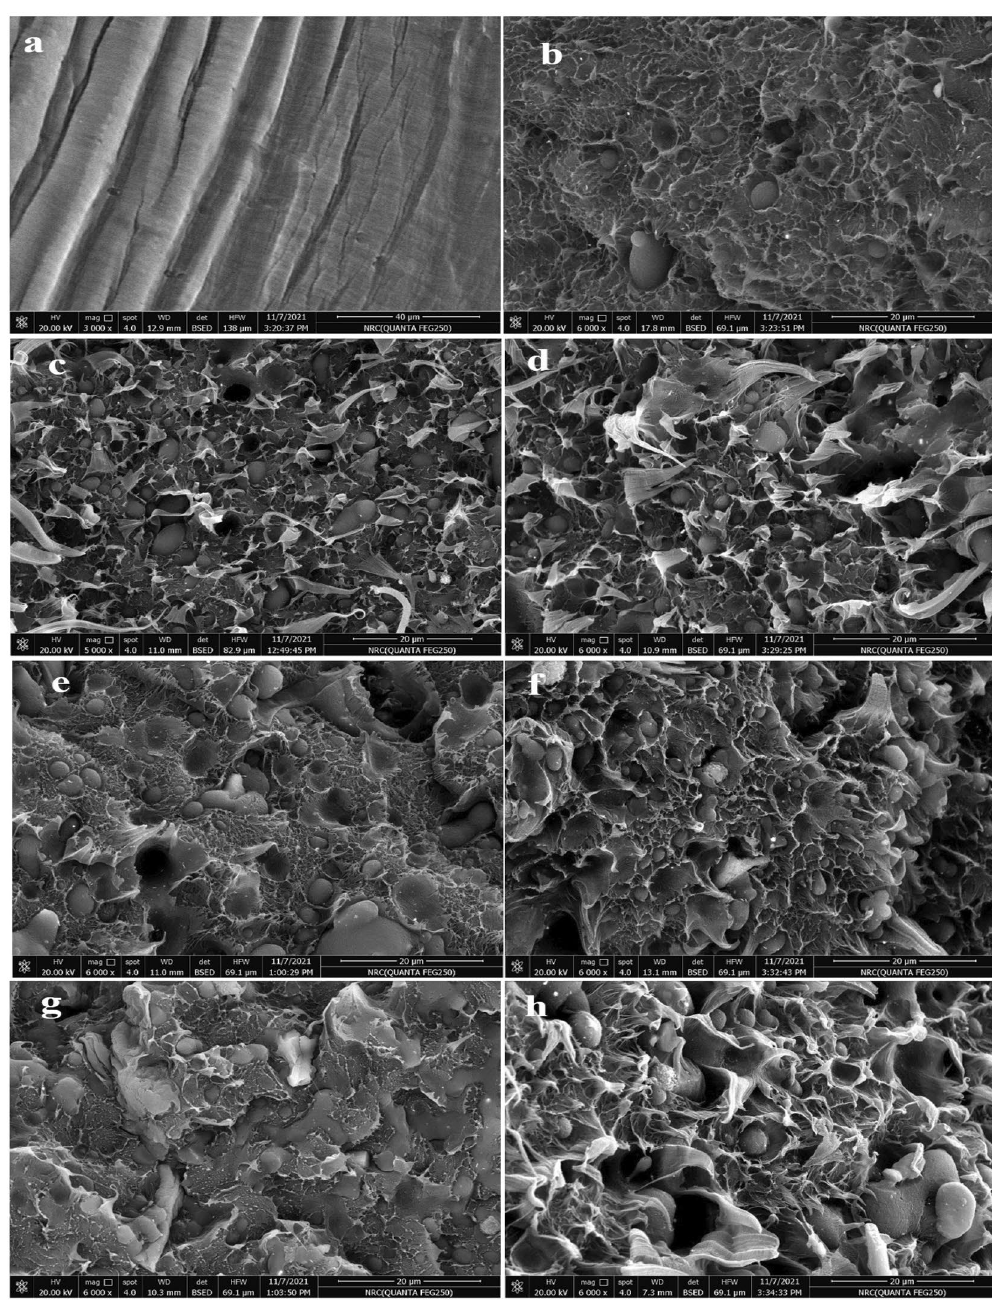
Figure 5. SEM image of pure LDPE ( a ), WPE ( b ), NFPC10%SF ( c ), NFPC20%SF ( d ), NFPC10%Sub ( e ), NFPC20%Sub ( f ), NFPC10%SSF ( g ), and NFPC20%SSF ( h